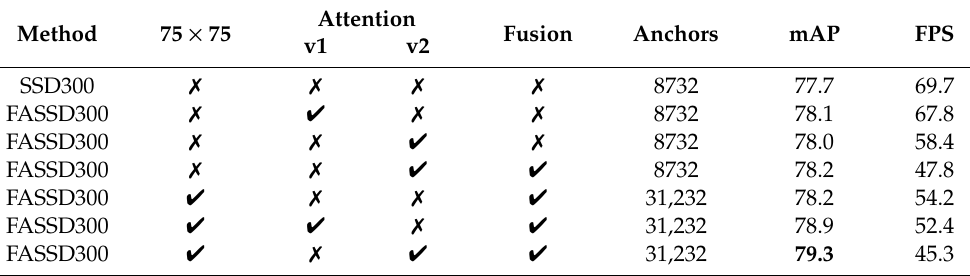
Table 3. Results of the ablation study on PASCAL